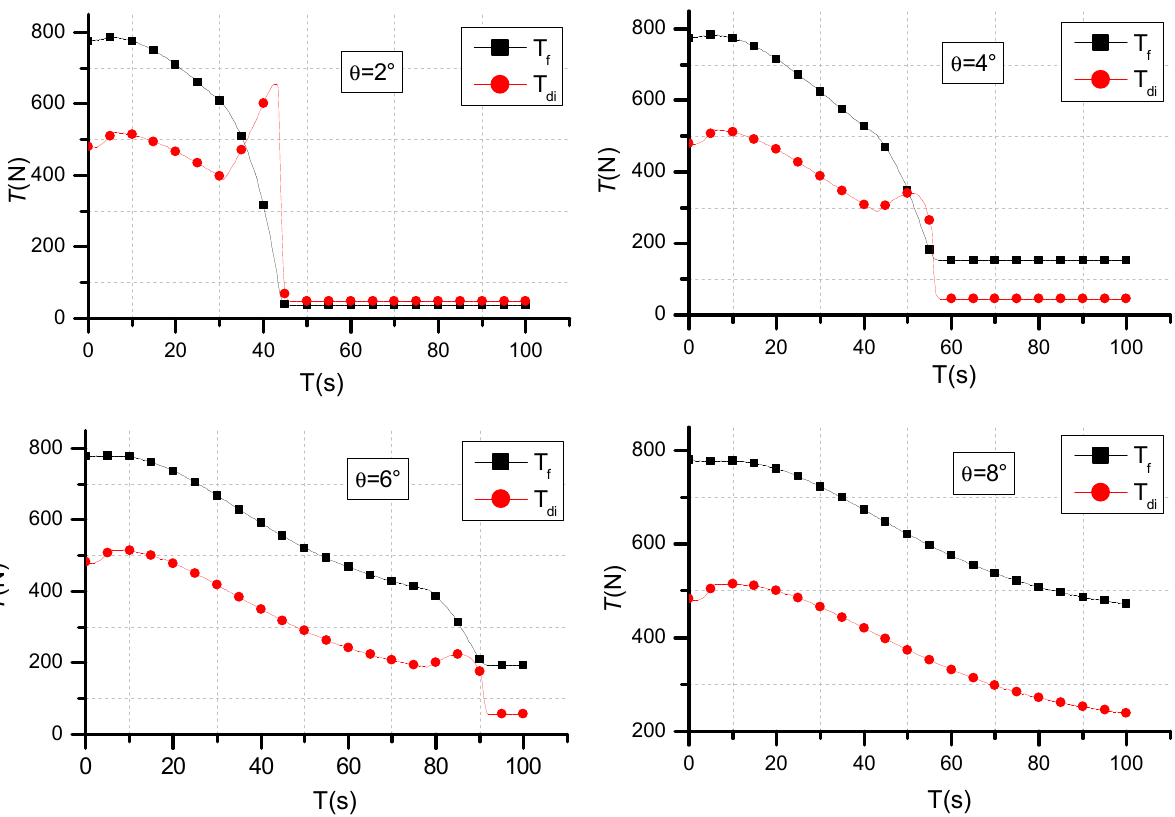
Figure 11. Power data corresponding to different pitch angles.